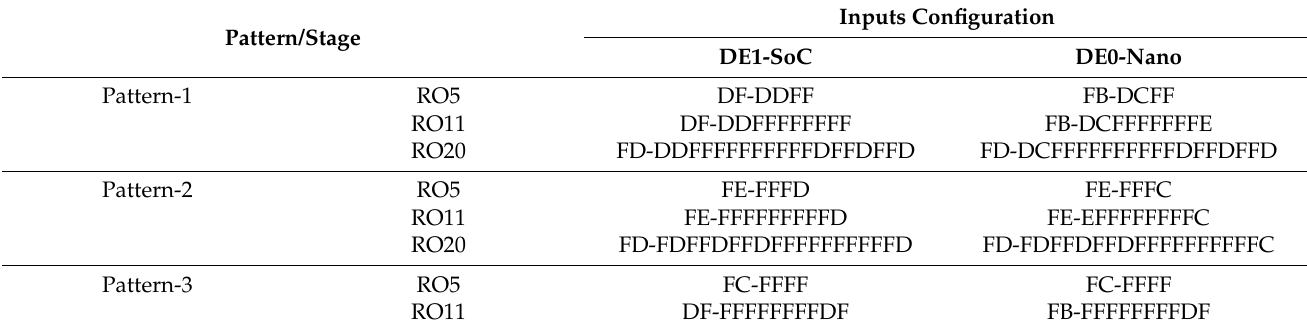
Table 3. Configuration of LUT inputs of all patterns in DE1-SoC and DE0-Nano.